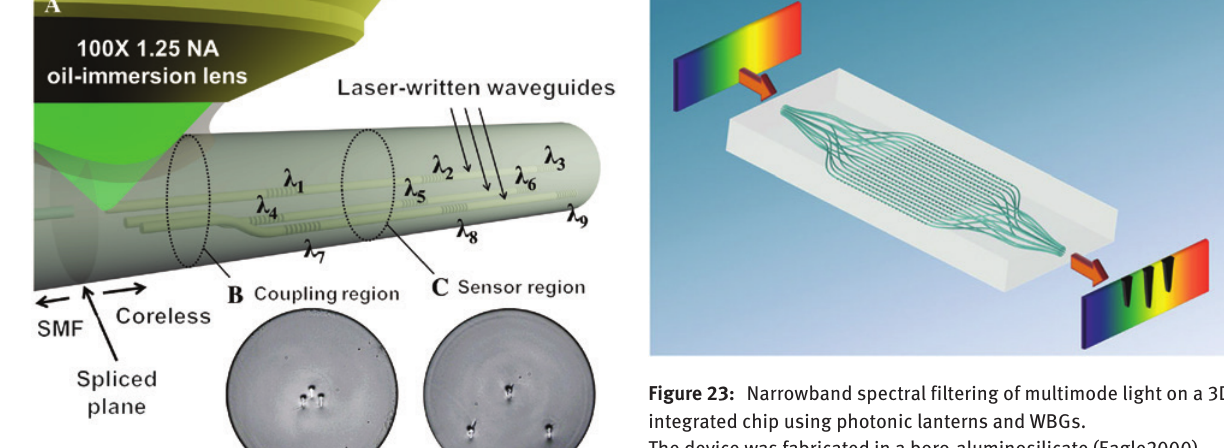
(Figure 22). Each coupler arm consisted of three cascaded WBGs with 5 nm increments starting at 1280 nm. Interro- gation was made possible through a fusion-spliced single- mode fibre at a 1 kHz sampling frequency. The geometry of nine axially and radially distributed WBG sensors allowed for simultaneous temperature and strain measurements to be made, from which real-time shape and thermal pro- files were calculated. The fibre sensor was calibrated for bend sensing up to 0.025 mm − 1 curvature and tempera- tures up to 250 ° C.